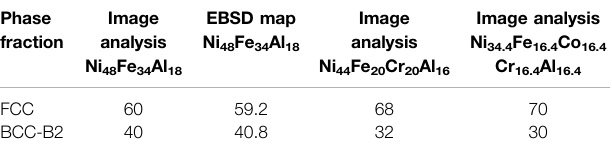
TABLE 2 | Phase fractions in as-cast samples from image analysis and electron backscatter diffraction (EBSD) mapping, in area%. Phase fraction